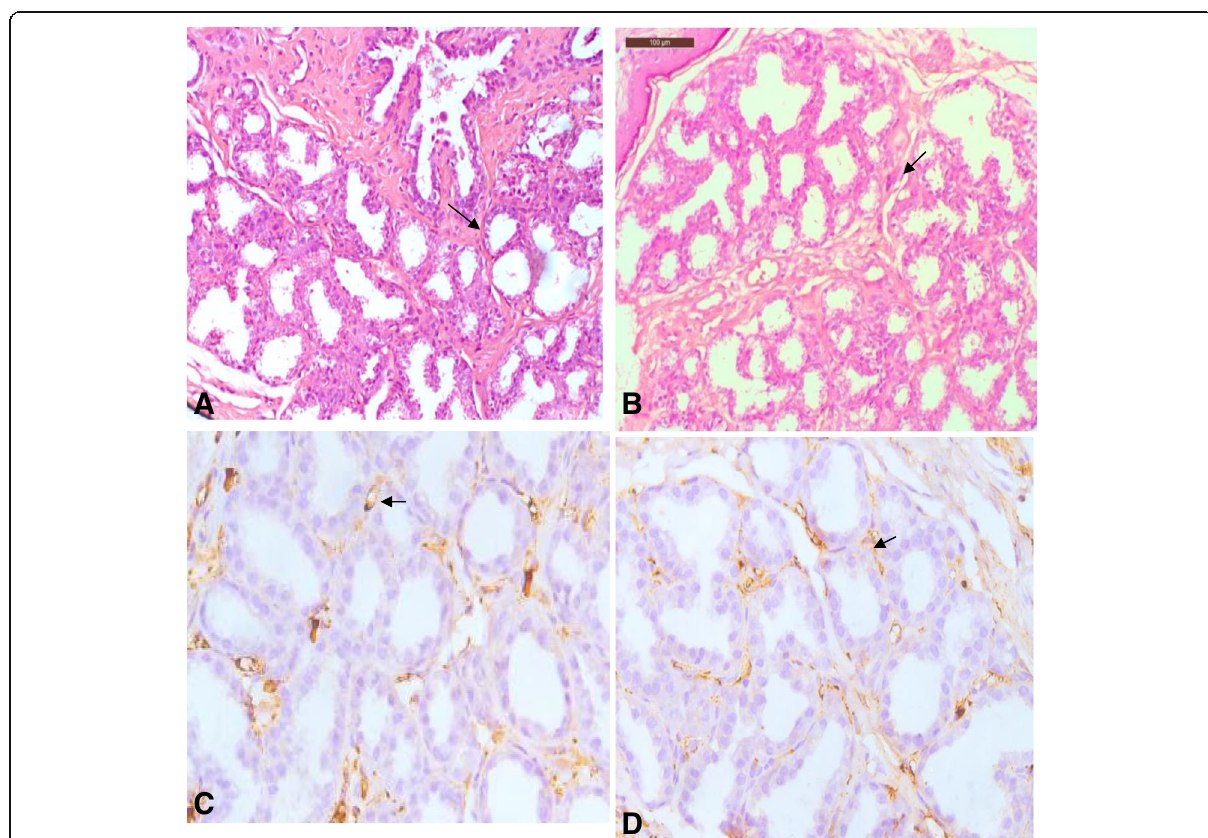
Fig. 3 a In mammary gland (bar = 100 μ m), the stromal connective tissue further recedes (arrow) and the alveolar buds progressively increased in the control group. H&E, × 200. b In mammary gland (bar = 100 μ m), the stromal connective tissue further recedes (arrow) and the alveolar buds progressively increased in 5 mg BPA-treated group. H&E, × 200. c The epithelial of ducts does not show positive staining but stromal tissue (arrow) shows faint positive staining in control group of the mammary gland (bar = 50 μ m), × 400. d The epithelial of ducts does not show positive staining but stromal tissue (arrow) shows faint positive staining in 5 mg BPA-treated group of mammary gland (bar = 50 μ m), ×